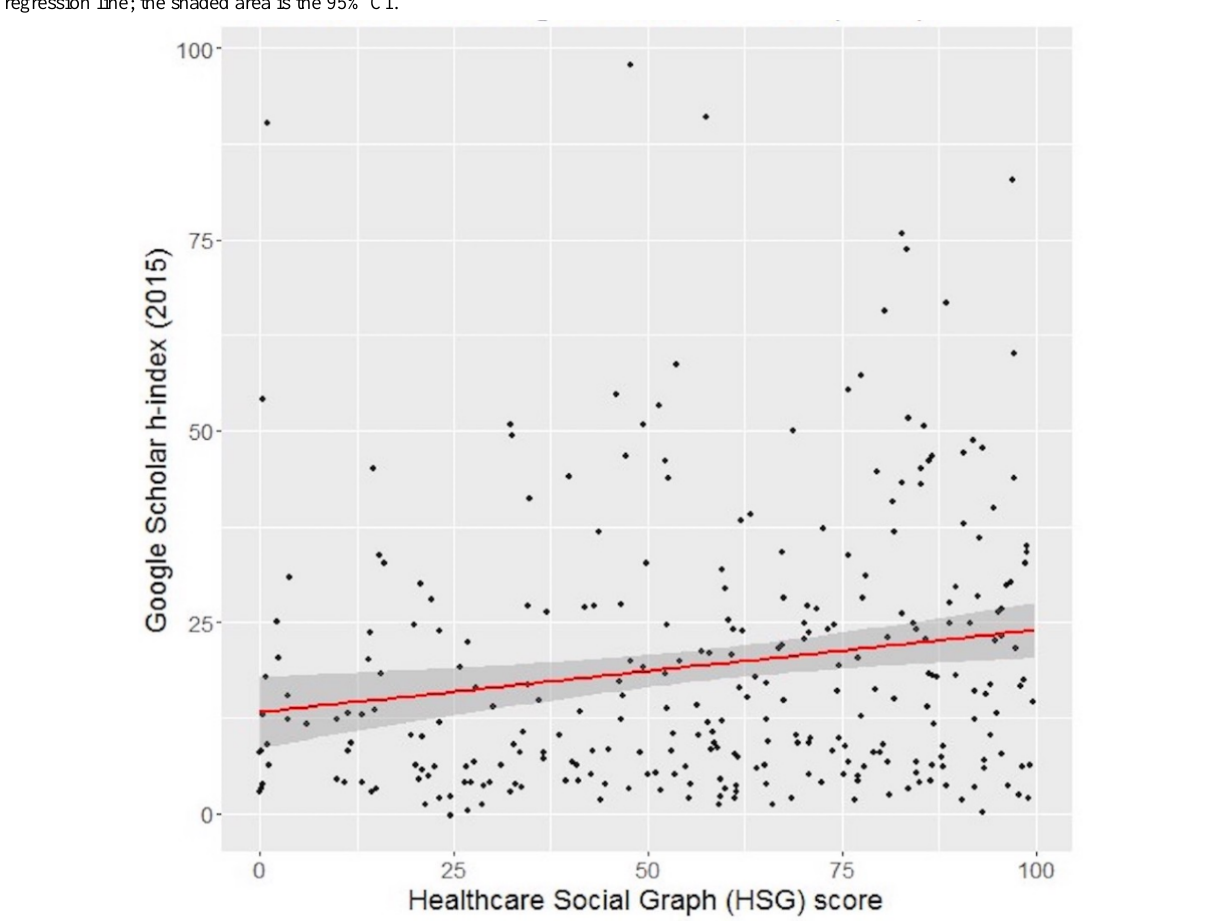
Figure 2. Correlation between HSG scores and Google Scholar 2015 h-indexes. Spearman correlation coefficient ρ =0.203 (N=286). The red line is the regression line; the shaded area is the 95%